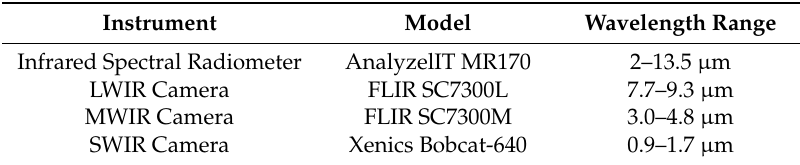
Table 1. Instrument specifications.